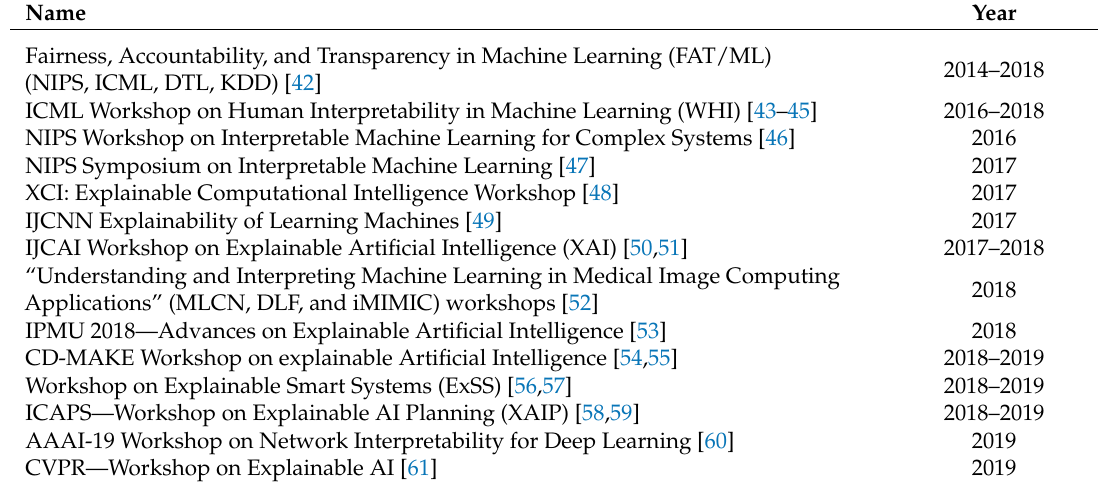
Table 1. Scientific events with focuses on